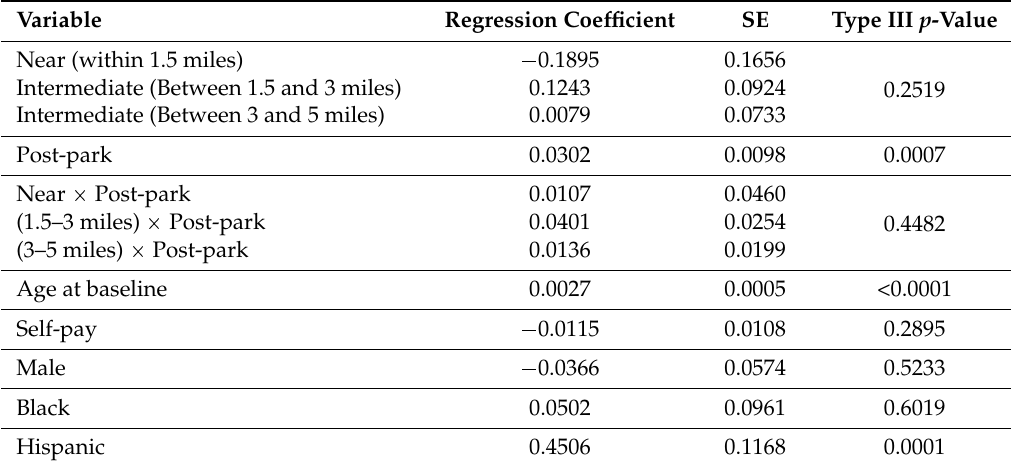
Table 3. Relationship between the interaction between the park and being near to the park and BMI z-scores compared to children living far from the park (>5 miles).